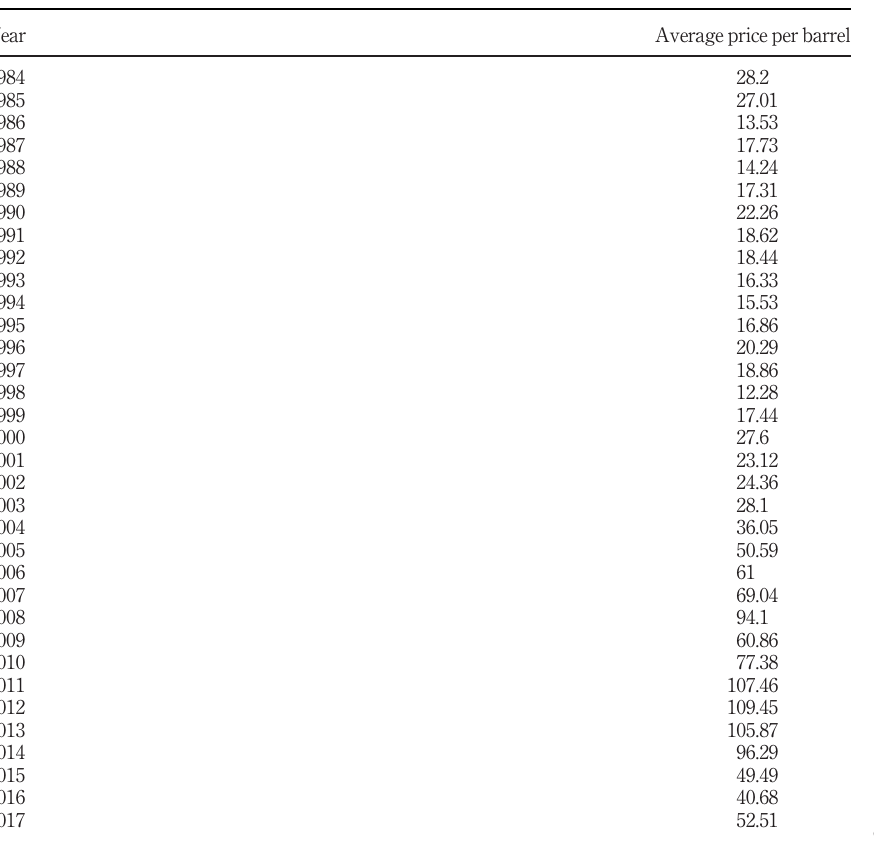
OPEC crude oil price from 1984 to 2017